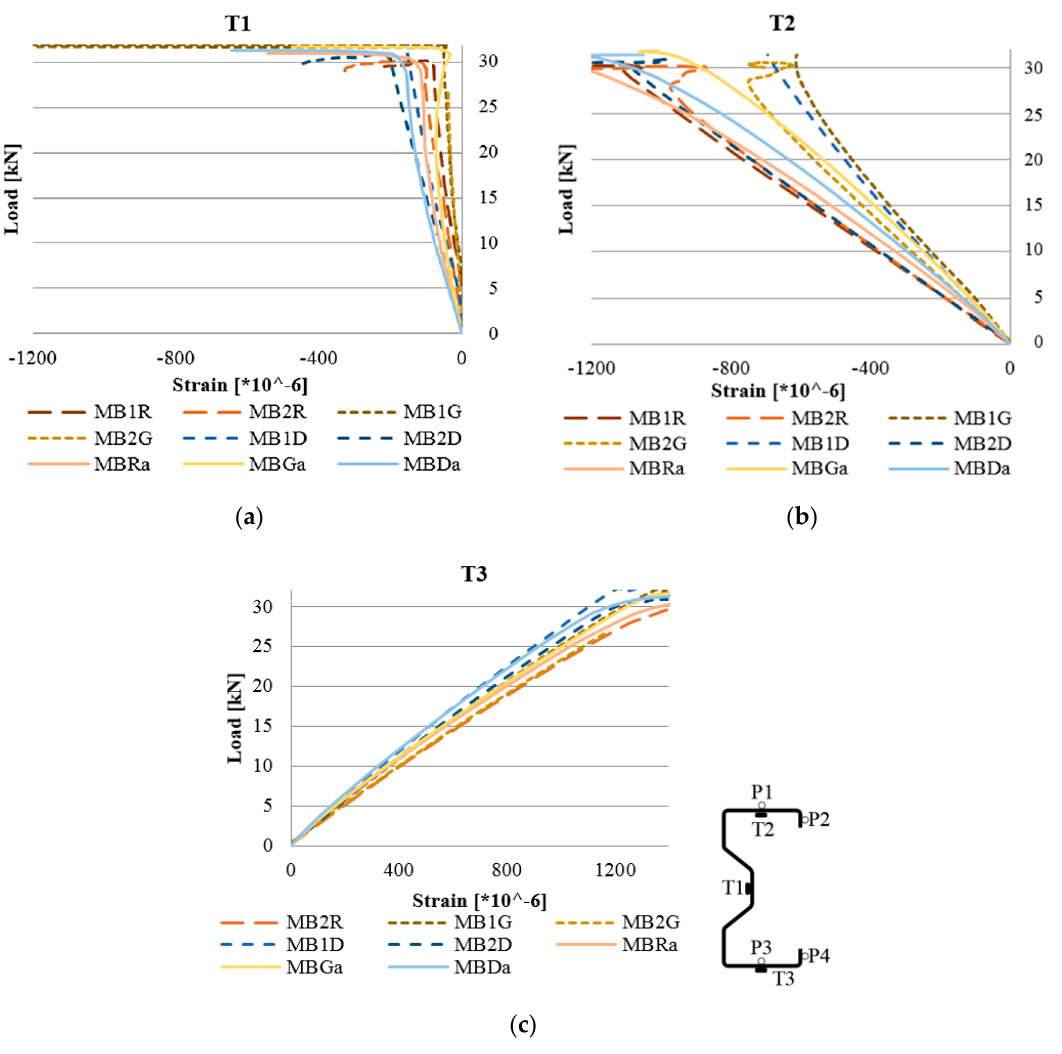
Figure 12. Load–strain relationship obtained from electrical resistance strain gauges in a laboratory test and at similar points in the finite element (FE) model: ( a ) in place of a strain gauge T1, ( b ) in place of a strain gauge T2, and ( c ) in place of a strain gauge T3.